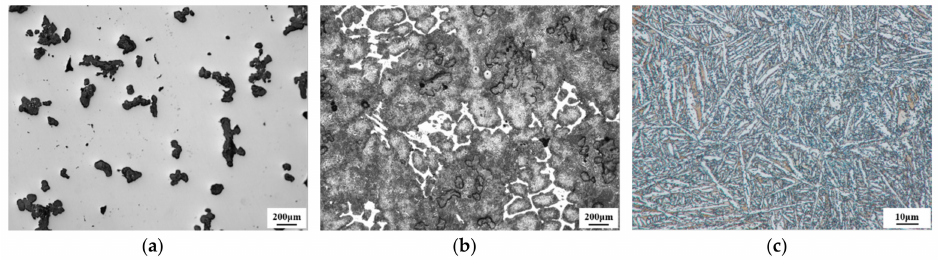
Figure 3. Graphite morphology ( a ) and microstructure of ductile cast iron (DCI) before the cladding process at low ( b ) and high ( c ) magnification.